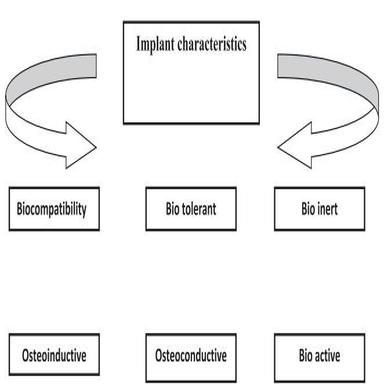
Primary properties present in medical implants.